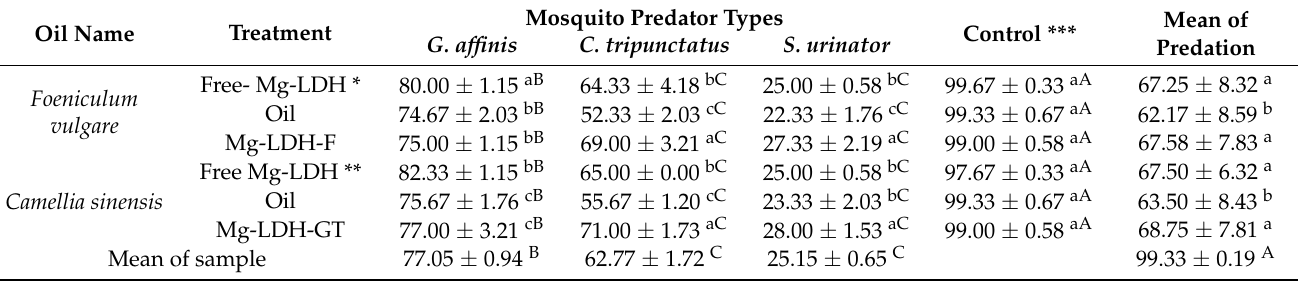
Table 8. The mean number of mosquito larvae, Culex pipiens consumed by some predators before and after being treated with fennel and green tea oil, and their Mg-LDH under laboratory